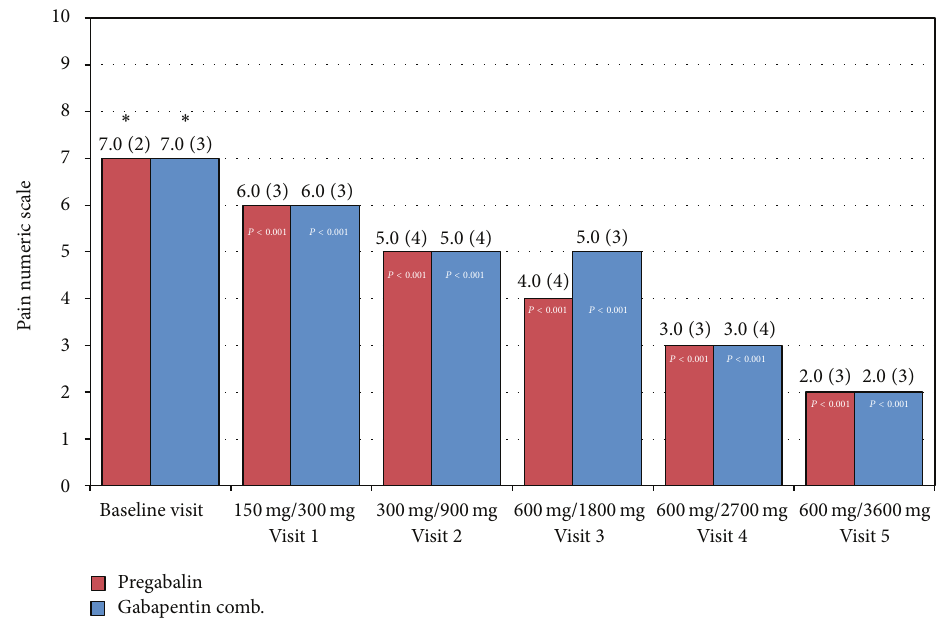
Figure 2: Median comparison per visit, between gabapentin-B complex and pregabalin, in pain intensity reduction, per visit and dose. Pain Visual Analog Scale (VAS), median (interquartile range) per visit, per protocol population. ∗ Statistically significant change from baseline visit, 𝑃 < 0.05 . HbA1c: glycated hemoglobin, BMI: body mass